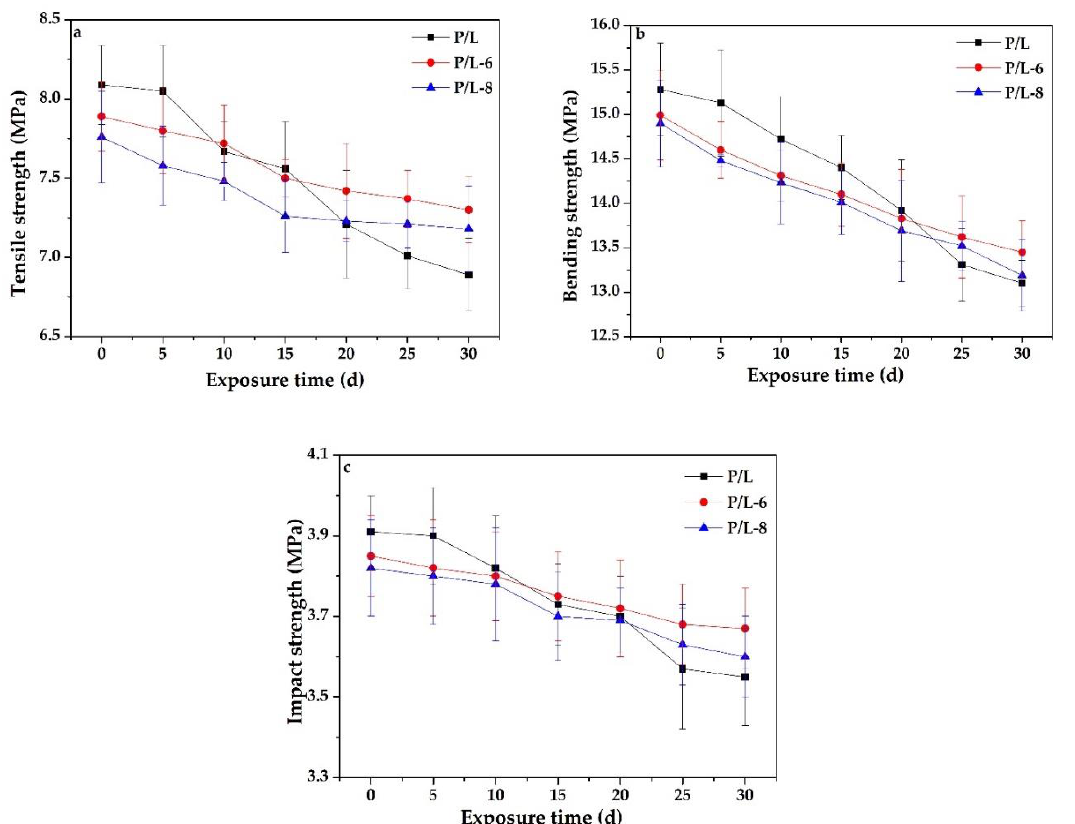
Figure 4. Mechanical properties of samples before and after accelerated aging: ( a ) tensile strength; ( b ) bending strength; and ( c ) impact strength.